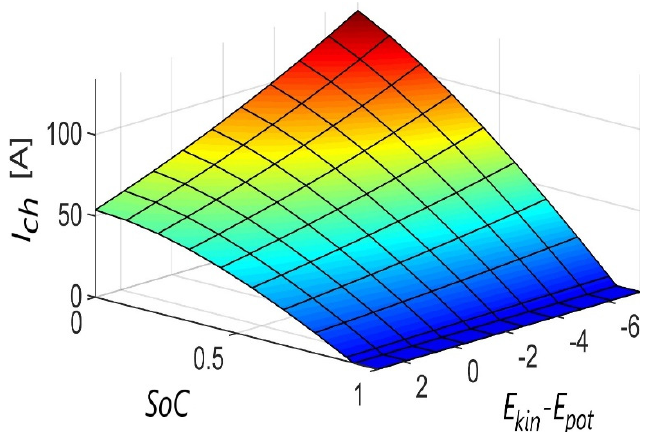
Figure 17. Supercapacitor grid charging current surface for the minimum gradient algorithm.